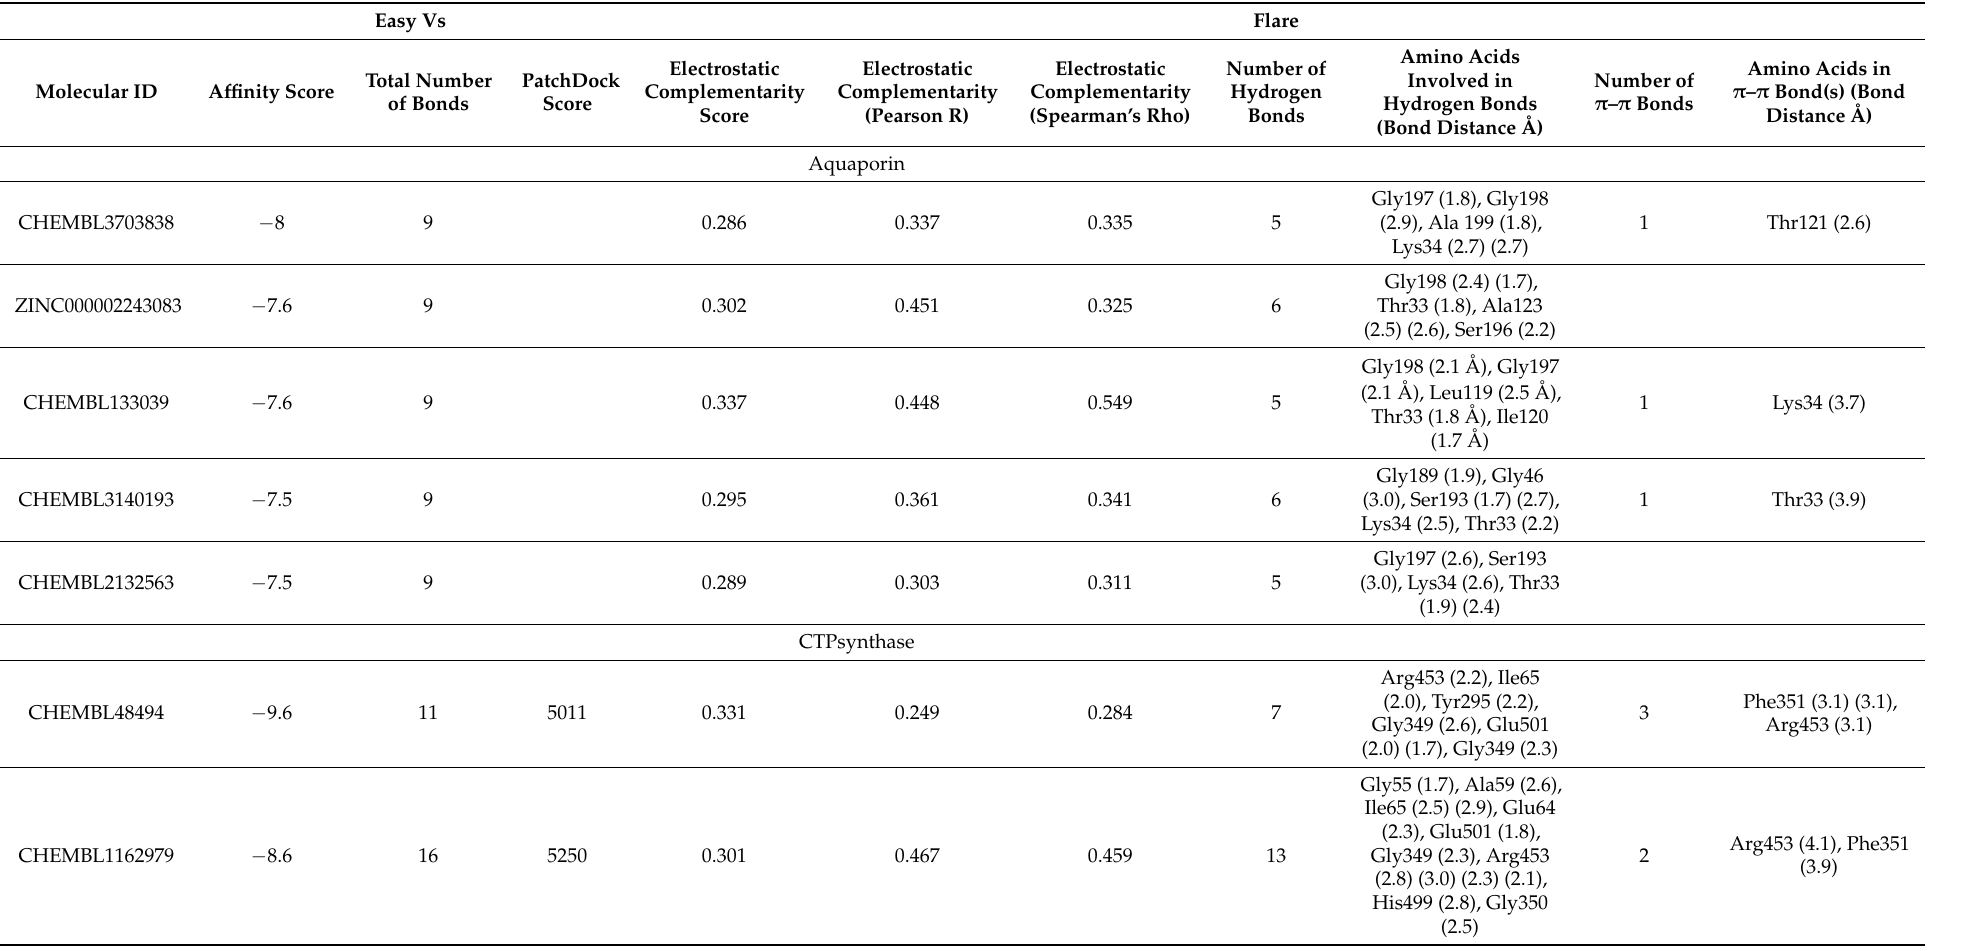
Table 3. Binding affinities, EC scores, and interactions between the five selected compounds and the corresponding protein